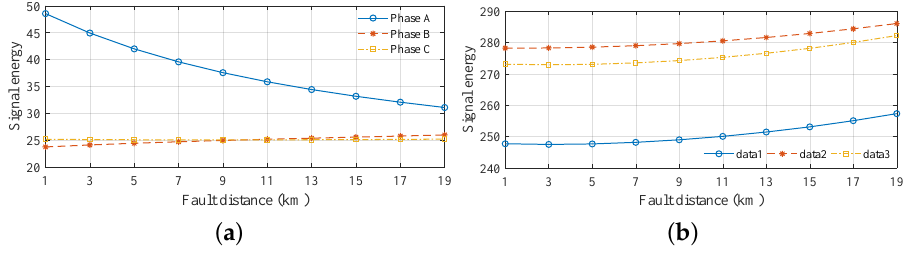
Figure 3. Variation of three phase ( a ) current and ( b ) voltage signal energy during the a-g fault with the fault distance for the grid-tied radial mode